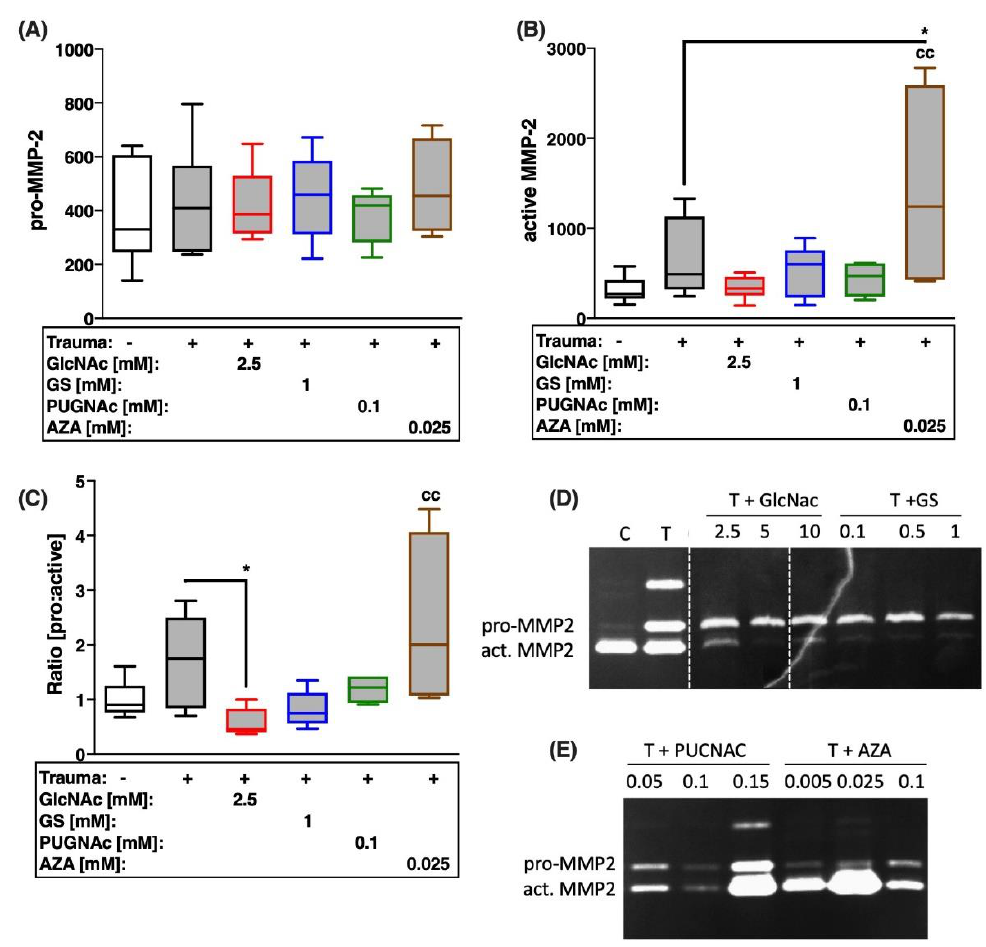
Figure 6. Effects of glucosamine treatment or addition of inhibitors on trauma-induced secretion and activation of MMP-2 7 days after trauma. Release of ( A ) pro-MMP-2 and ( B ) active MMP-2 was measured by means of gelatin zymography, as exemplarily demonstrated in ( D , E ). ( C ) Ratio of zymographically detectable pro-MMP-2 to active MMP-2. Statistical analysis: ( A – C ) one-way ANOVA. Significant differences between groups were depicted as: [versus T] * = p < 0.05; [versus C] cc = p < 0.01; all data sets n ≥ 5. Blank box = unimpacted control (C), shaded boxes = traumatized cartilage explants (T).